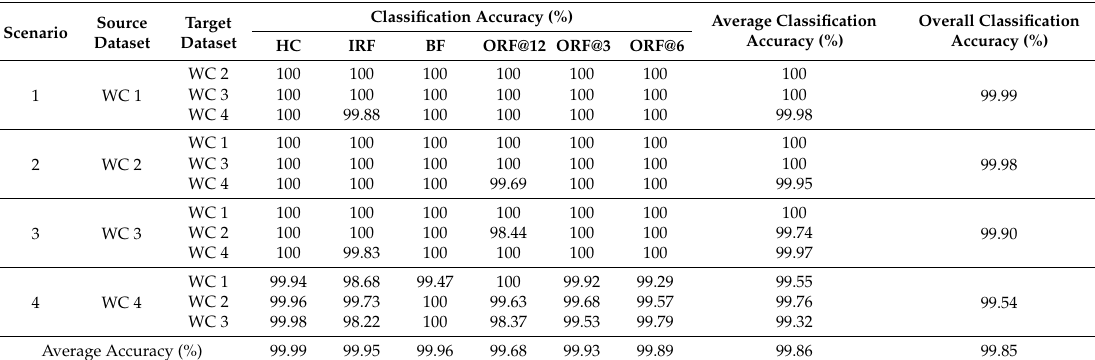
Table 3. Diagnostic performance of the proposed model under different scenarios.